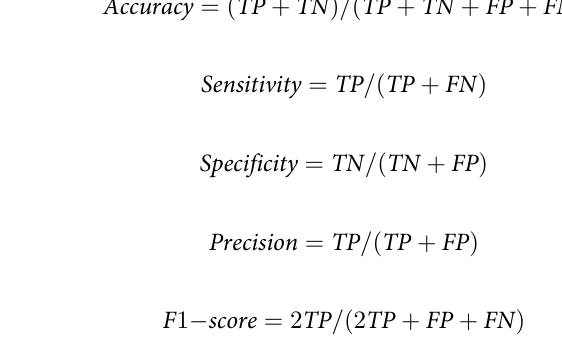
Where TP is true positive, TN is true negative, FP is false positive and FN is false negative.